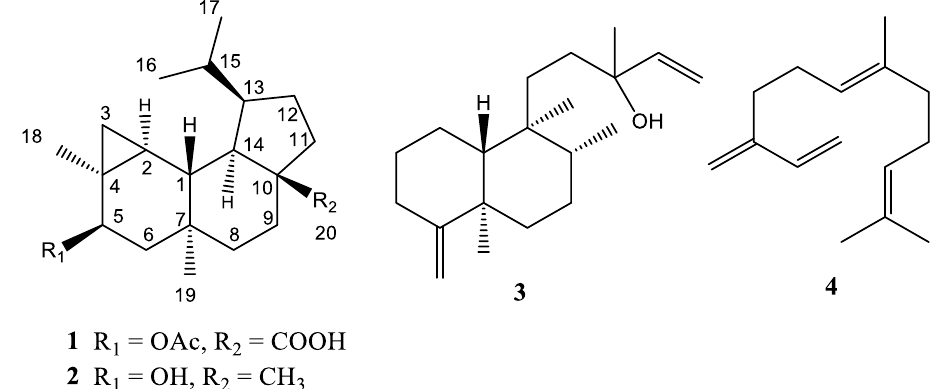
Table 1 1 H and 13 C NMR (600 and 150 MHz) data of 1 (in CDCl in ppm, J in